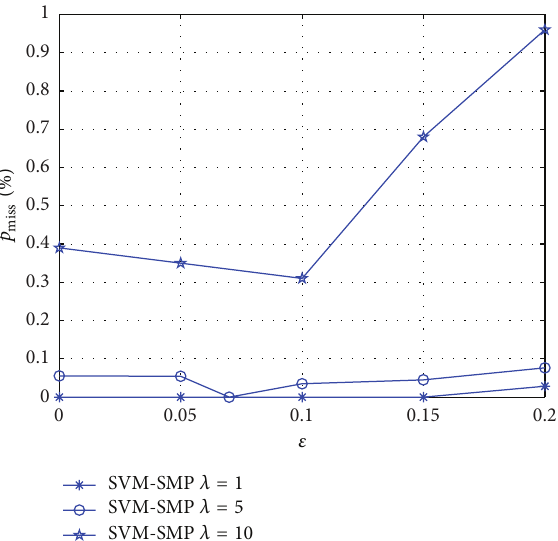
for CUs versus 𝜇 . miss